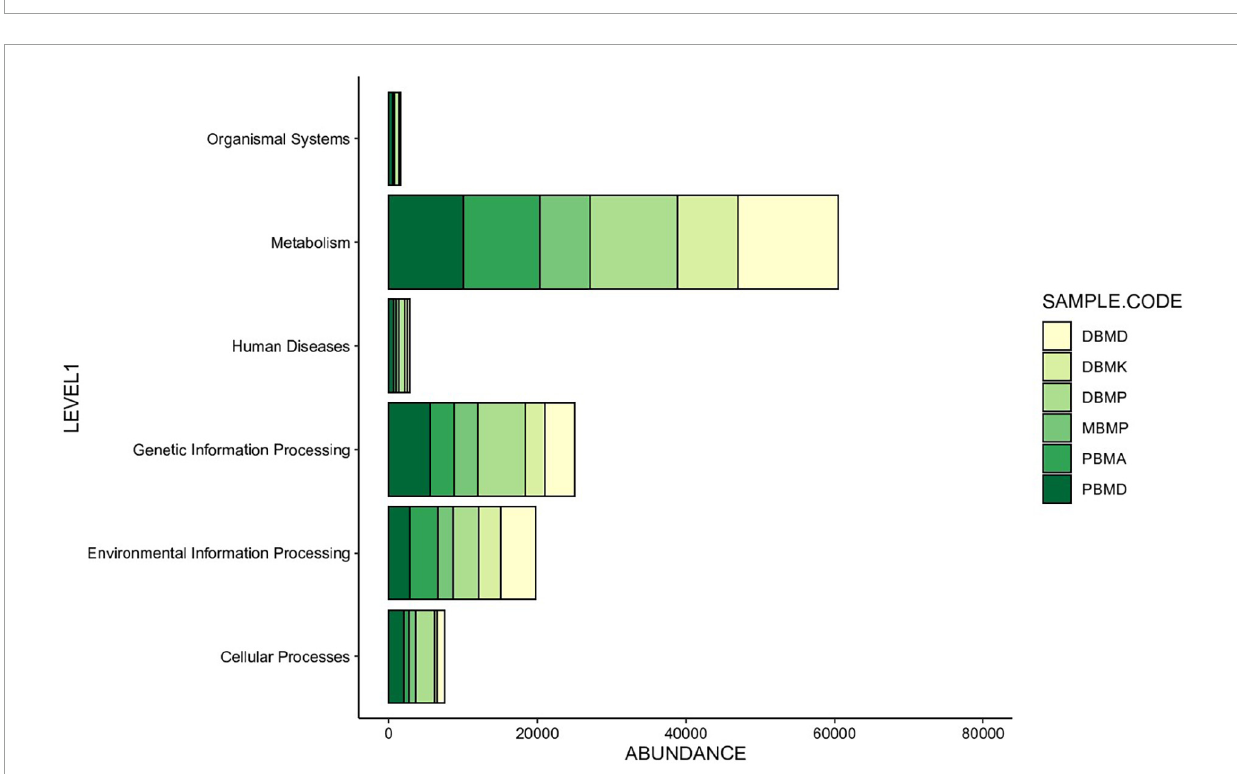
FIGURE8 KEGG (level 1) showing the highest number of genes annotated to pathways.